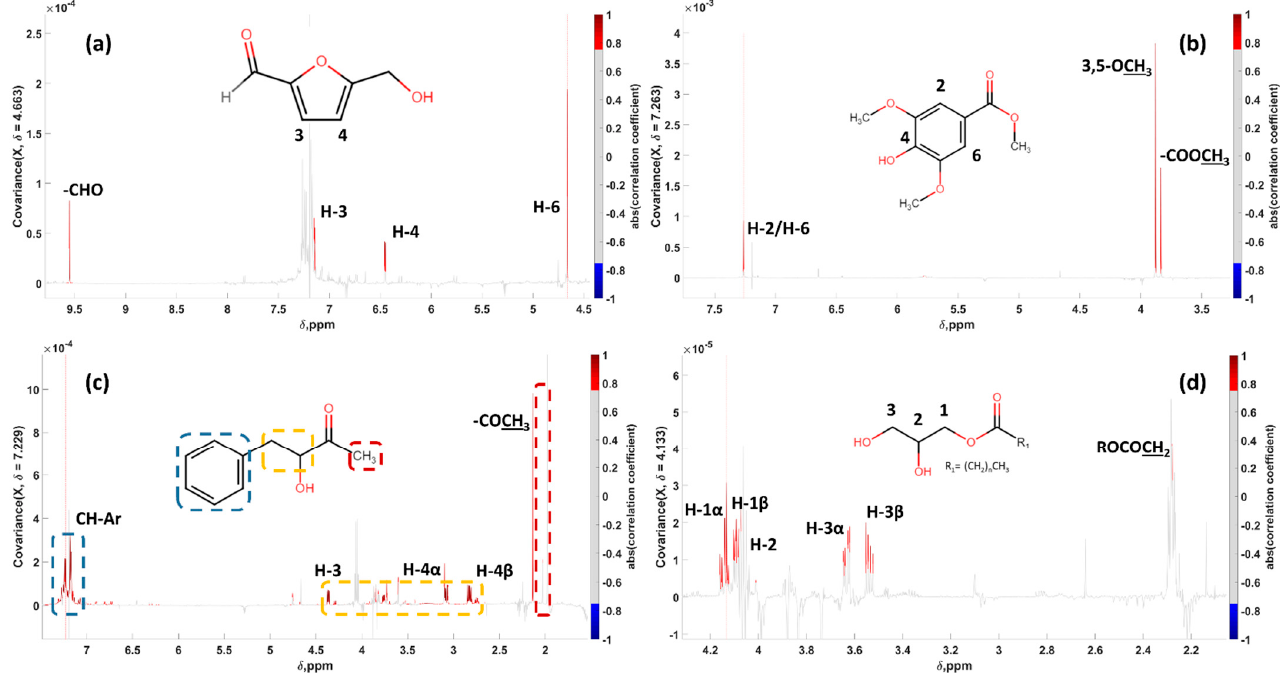
Figure 3. Statistical total correlation spectroscopy (STOCSY) 1D-pseudo-NMR spectra. ( a ) 5-HMF, “driver peak” at 4.663 ppm; ( b ) MSYR, “driver peak” at 7.263 ppm; ( c ) 3-hydroxy-4-phenyl-2-butanone, “driver peak” at 7.229 ppm; and ( d ) MG, “driver peak” at 4.133 ppm.